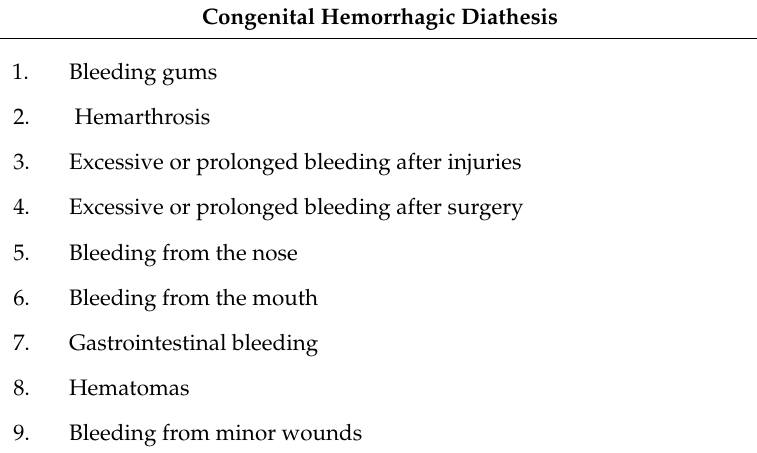
Table 1. Symptoms of congenital hemorrhagic